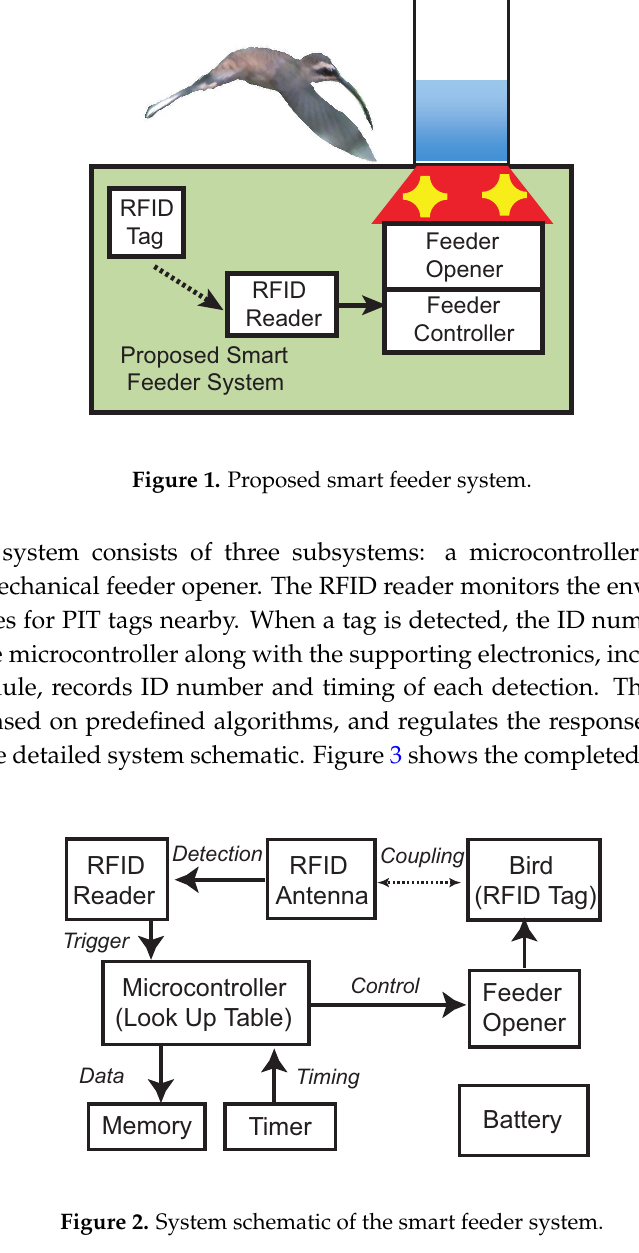
Figure 2. System schematic of the smart feeder